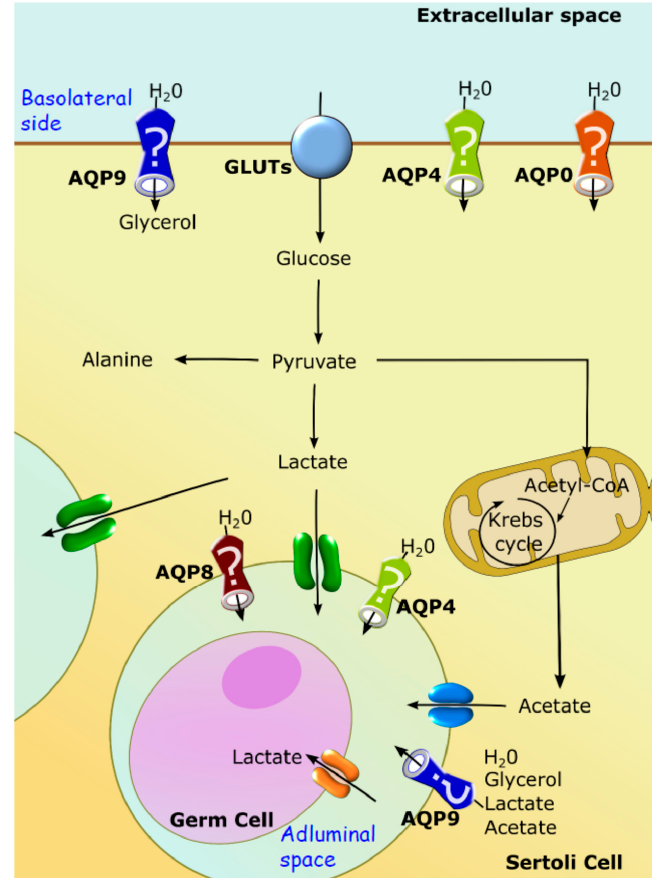
Figure 5. Schematic diagram of the possible subcellular localizations of AQPs in Sertoli cells and their possible link to metabolism. SCs express multiple AQP homologues, AQP0, AQP4, AQP8 and AQP9. The basolateral plasma membrane is believed to contain AQP0, AQP4 and AQP9. Basolateral AQP9 may be relevant for testicular metabolic cooperation. The SC adluminal plasma membrane contains AQP4, AQP8 and AQP9. Adluminal AQP9 may mediate the extrusion of metabolic intermediates such as lactate, acetate and glycerol (in addition to water). The functional significance of adluminal AQP4, an AQP highly permeable to water, and AQP8, a homologue conducting water and some other molecules, remains